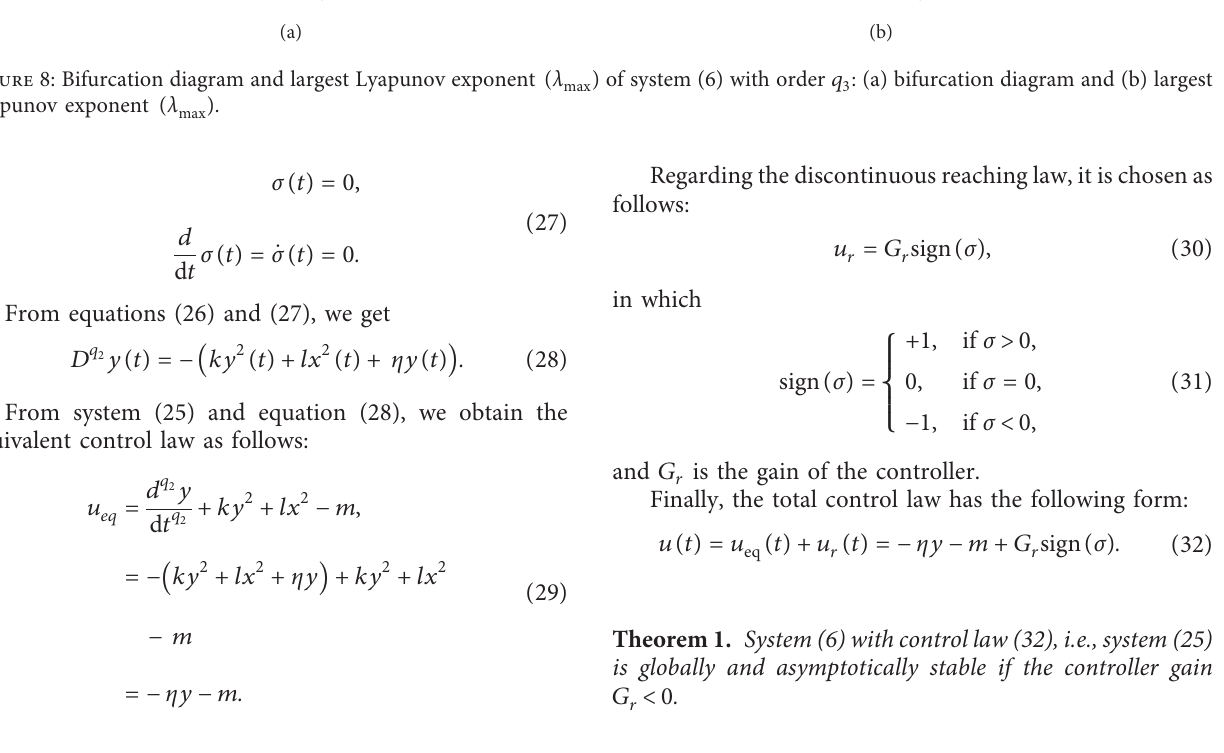
: (a) bifurcation diagram and (b) largest 3